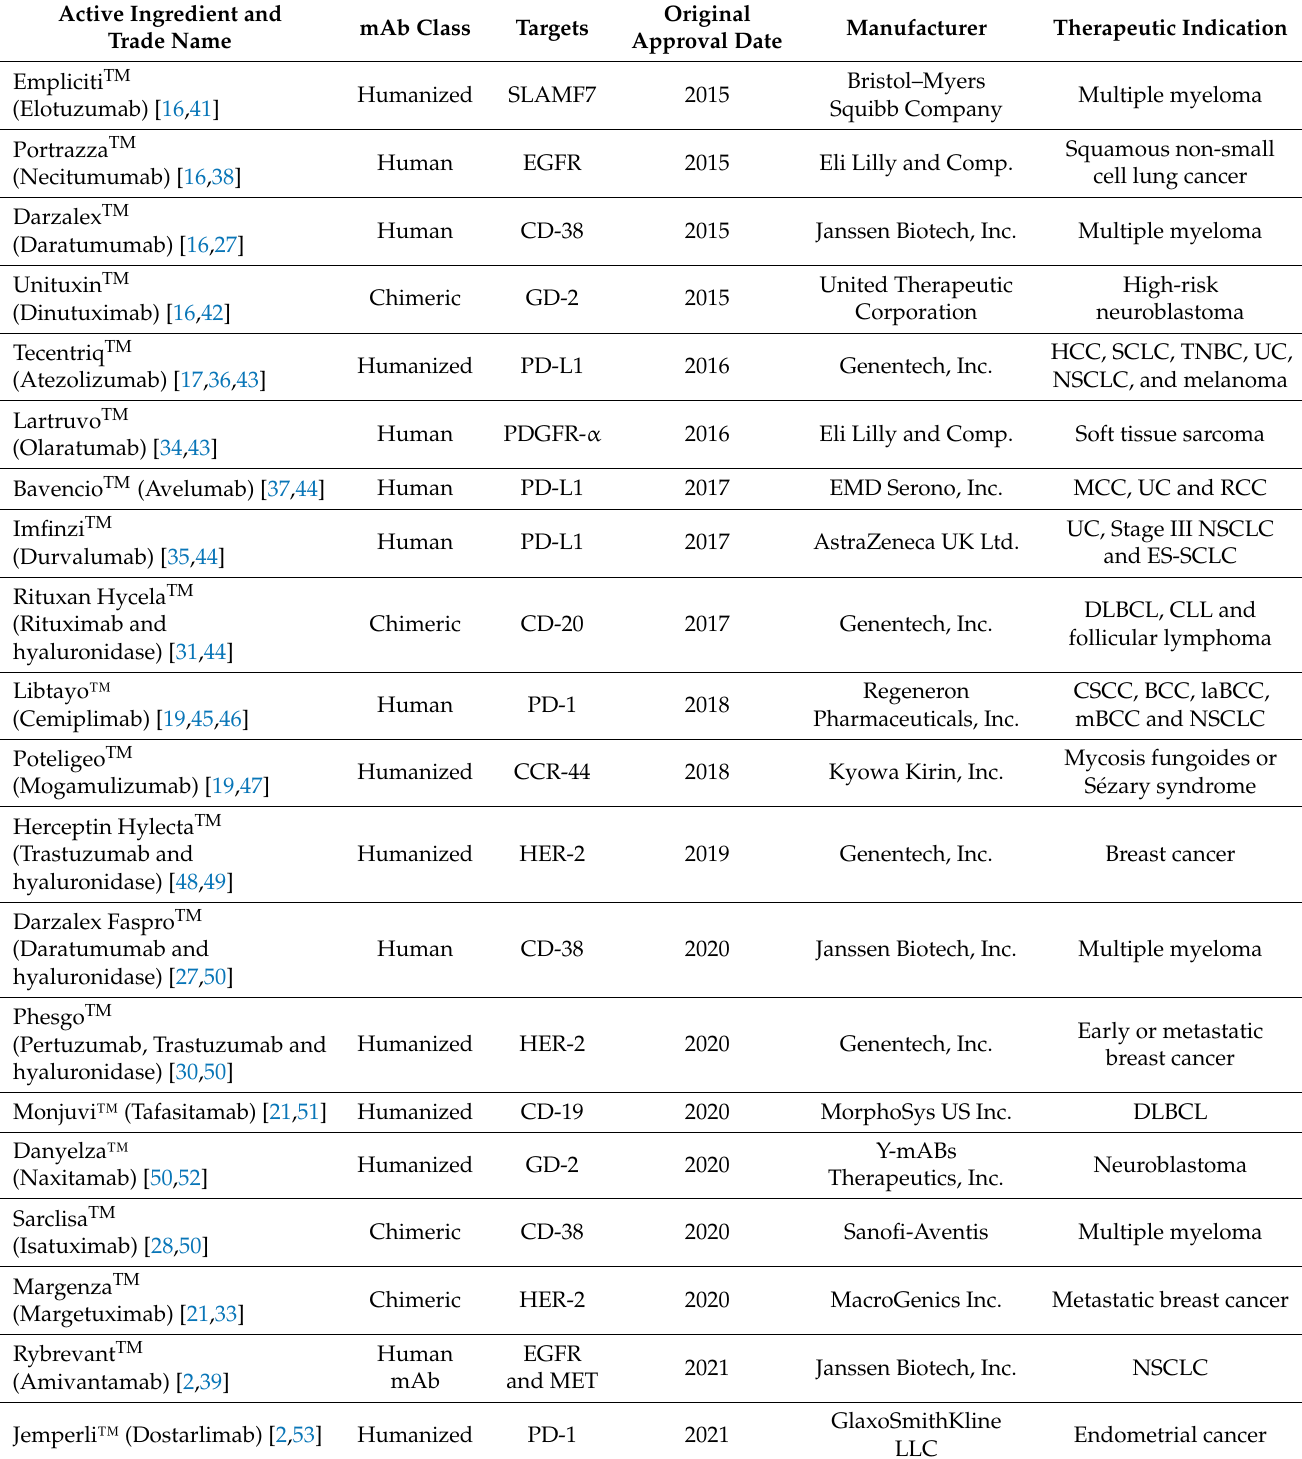
Table 2. Monoclonal antibodies for cancer approved by the Food and Drug Administration from 2015 to